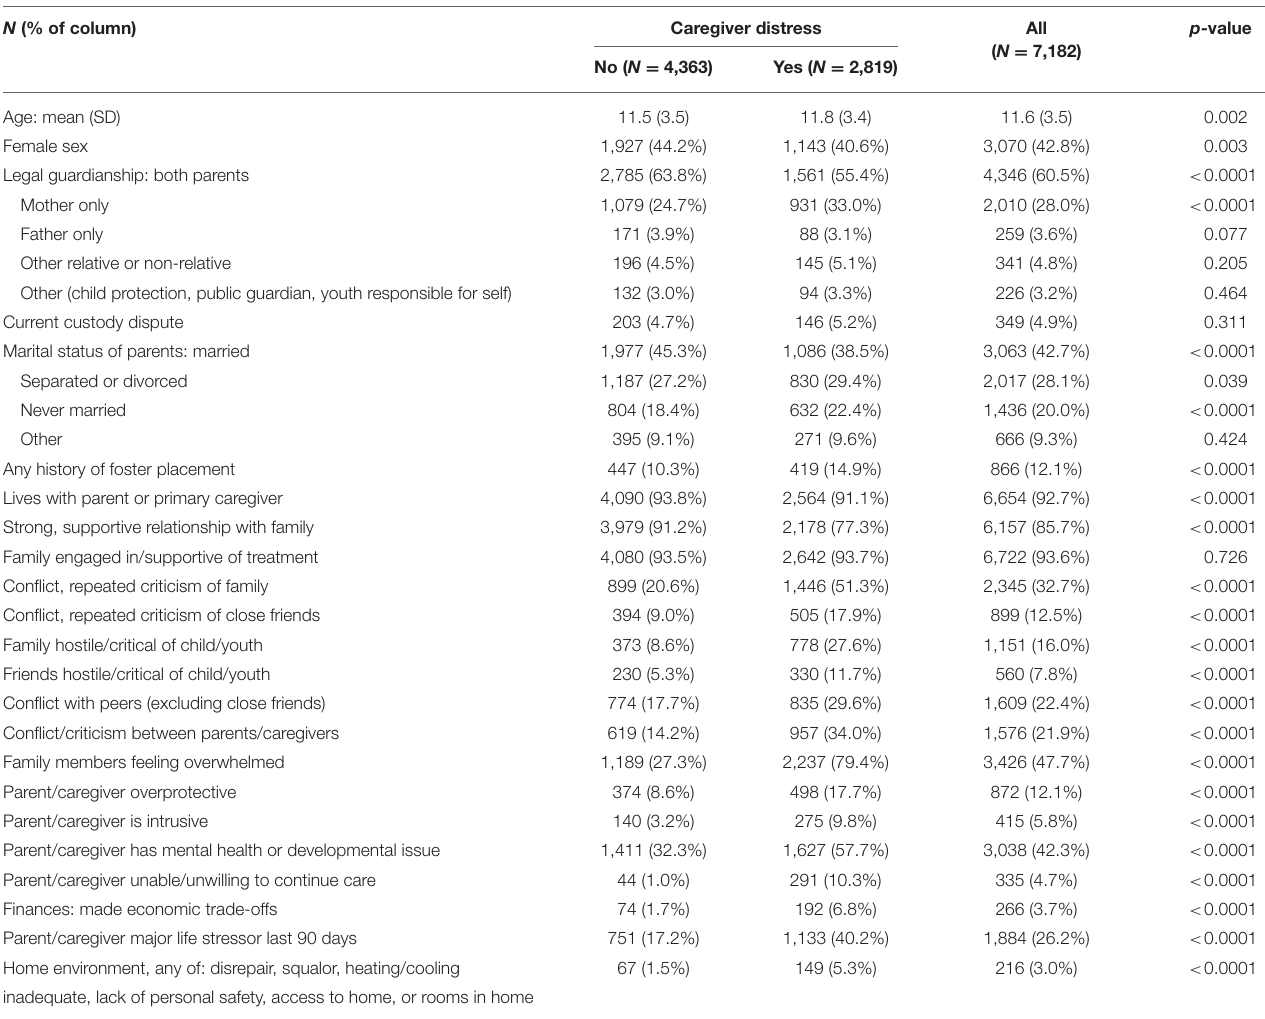
TABLE 1 | Sample characteristics at